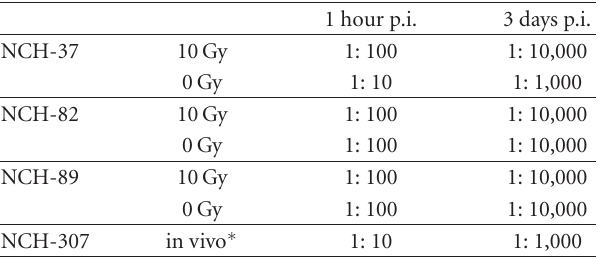
Table 2: Titer of infectious virus particles in the supernatant of irradiated (10Gy) or nonirradiated (0Gy) human high-grade glioma cell lines 1 hour and 3 days post H-1PV